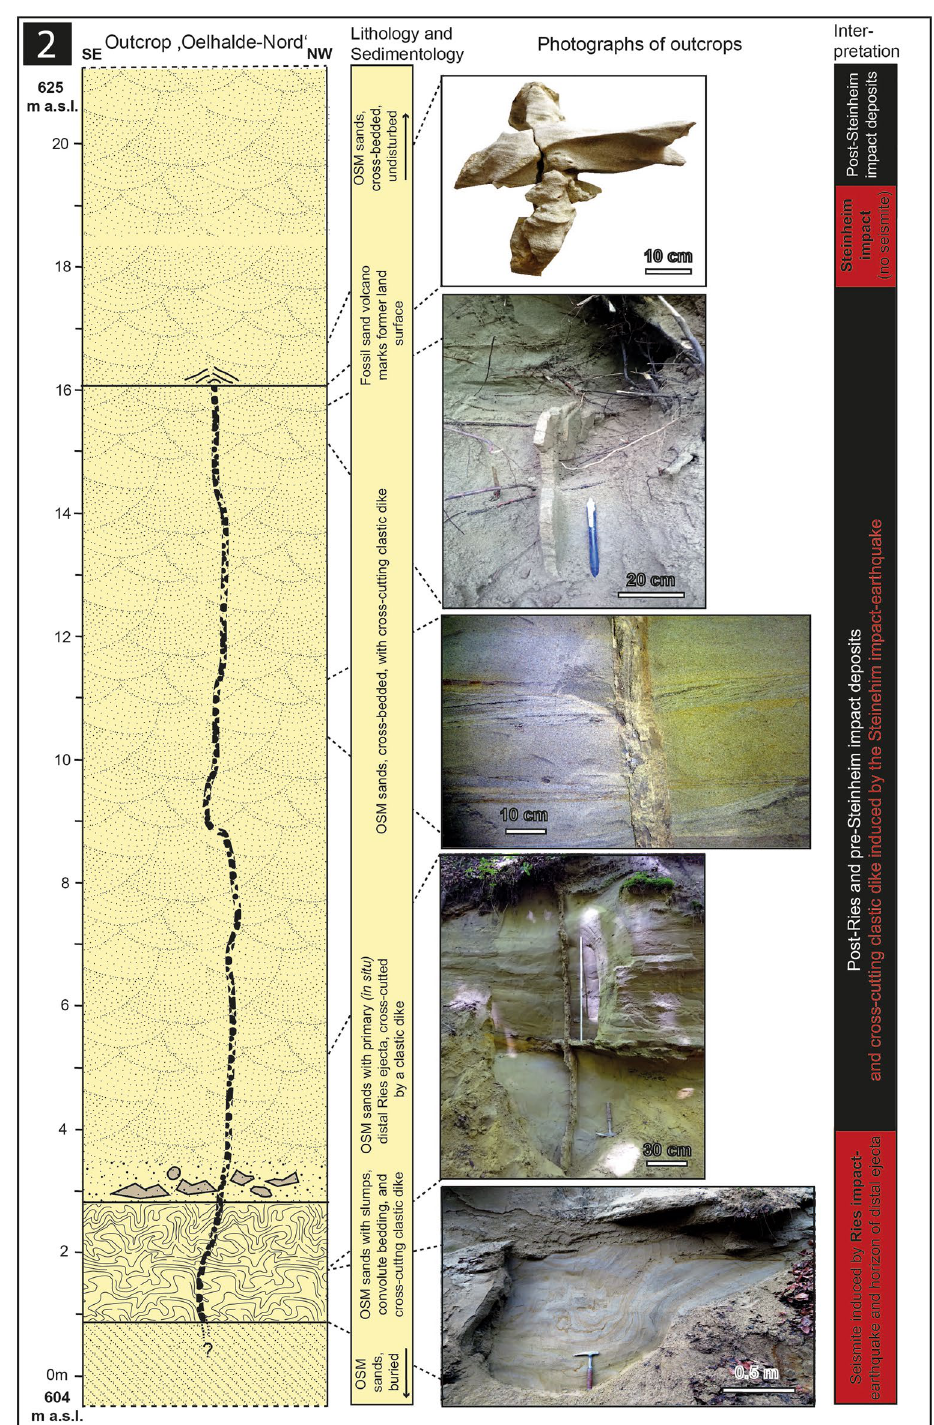
Figure 3. Schematic description of the sedimentological situation (left), outcrop photographs, and event stratigraphic interpretion of the sedimentologic succession (right) in the Tobel Oelhalde-Nord (Hochgeländ plateau south of Biberach an der Riß; outcrop no. 2 in the text). Two seismic events (Ries and Steinheim impact- earthquakes) are reported by the occurrence of the Ries seismite horizons with slumps and convolute bedding within sediments that formed the land surface at the time of the impact event, capped by distal Ries ejecta. The second impact-earthquake (Steinheim impact) caused the formation of a giant clastic dike that reached the palaeo-surface at the time of the second impact event. A succession of about 15 m of OSM sediments were deposited in the timespan between the two impact events; for more details about this outcrop see 16 ; all photographs taken by V.J.S. in